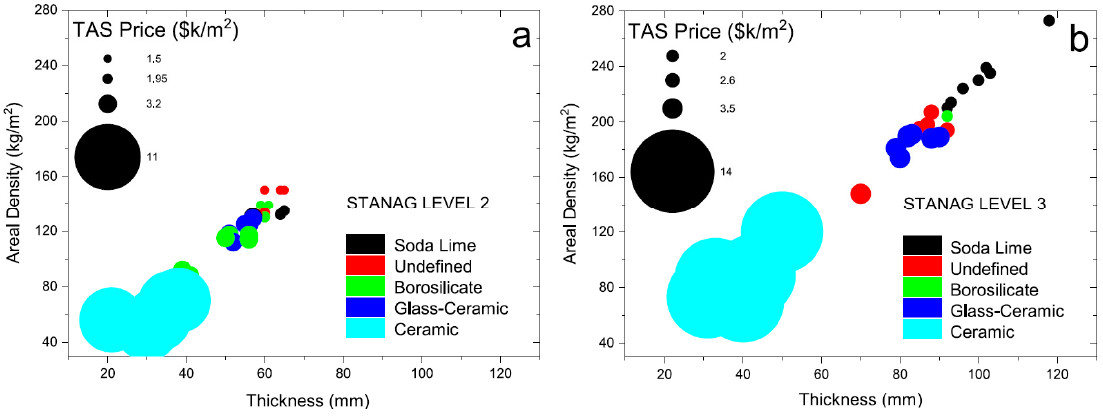
Figure 15. Comparison of transparent armor materials for STANAG 4569; ( a ) Level 2 and ( b ) Level 3 [65]. Reprinted with permission from Ref. [65]. Copyright 2017, copyright ELSEVIER.